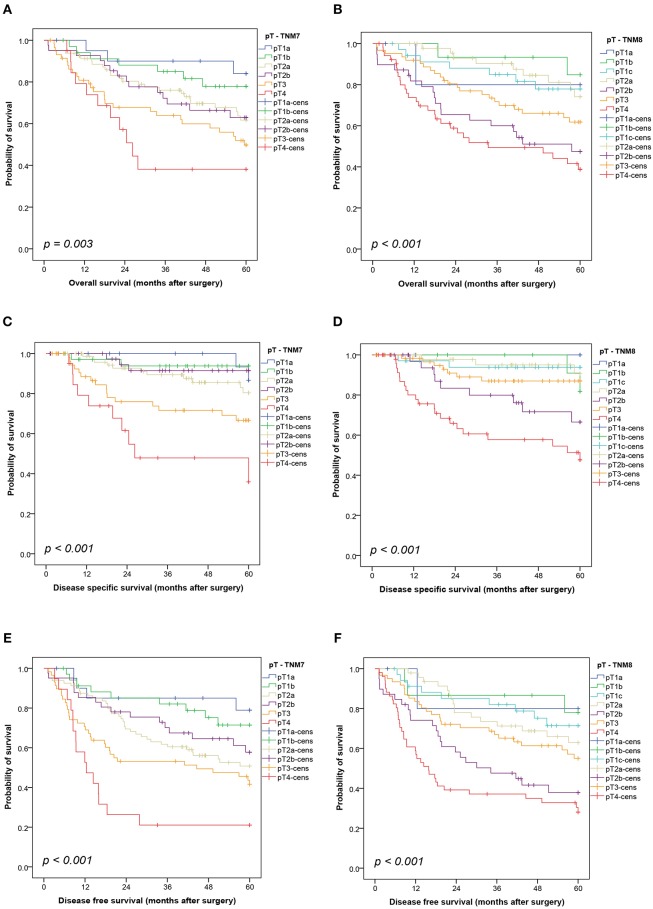
Kaplan-Meier curves showing the overall survival (A,B), disease-specific survival (C,D) and disease-free survival (E,F) by pT-descriptor according to the seventh and eighth editions of the TNM classification. Comparisons were conducted using a log-rank test. cens, censored.